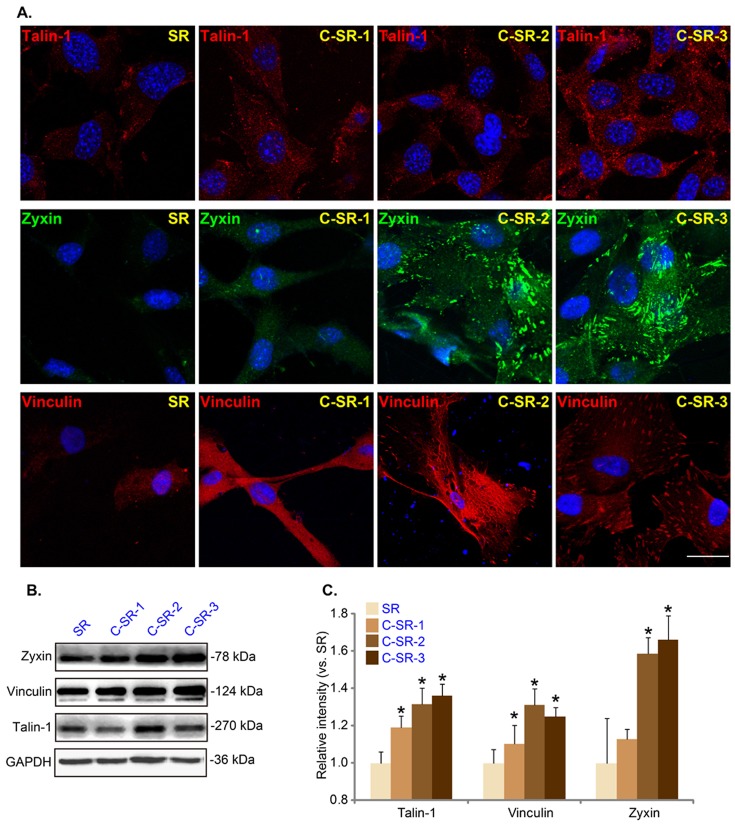
Dermal fibroblasts adhere more strongly to the surface of C-SR with increased expression levels of adhesion proteins.Immuno-fluorescence results (A) and western blots results (B and C) show the expressions and localization of talin-1, zyxin and vinculin in dermal fibroblasts cultured on SR or different C-SRs coated 6-well plate (48 hours). Note that there were significantly more expression levels of talin-1, zyxin and vinculin in dermal fibroblasts cultured on C-SRs than in other cells. *p<0.05 The difference was statistically significant when the substrate was compared to SR for detecting different adhesion protein. These experiments were repeated three times, similar results were obtained each time. Bar = 20 µm.